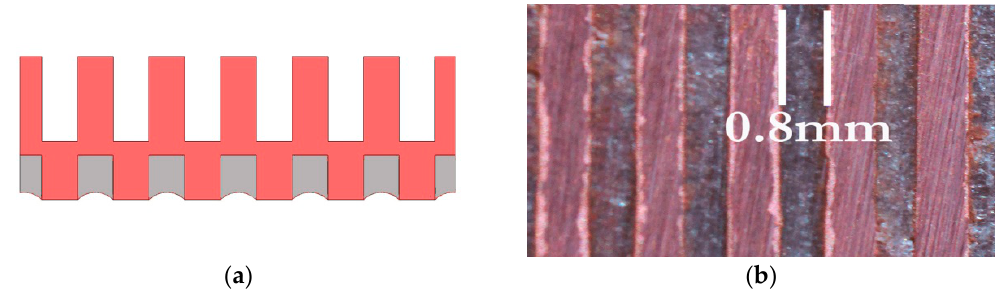
Figure 10. (a) Grooved target cross-section; the target material is grey while red is the copper substrate. (b) Face close-up with fused target material (grey color).